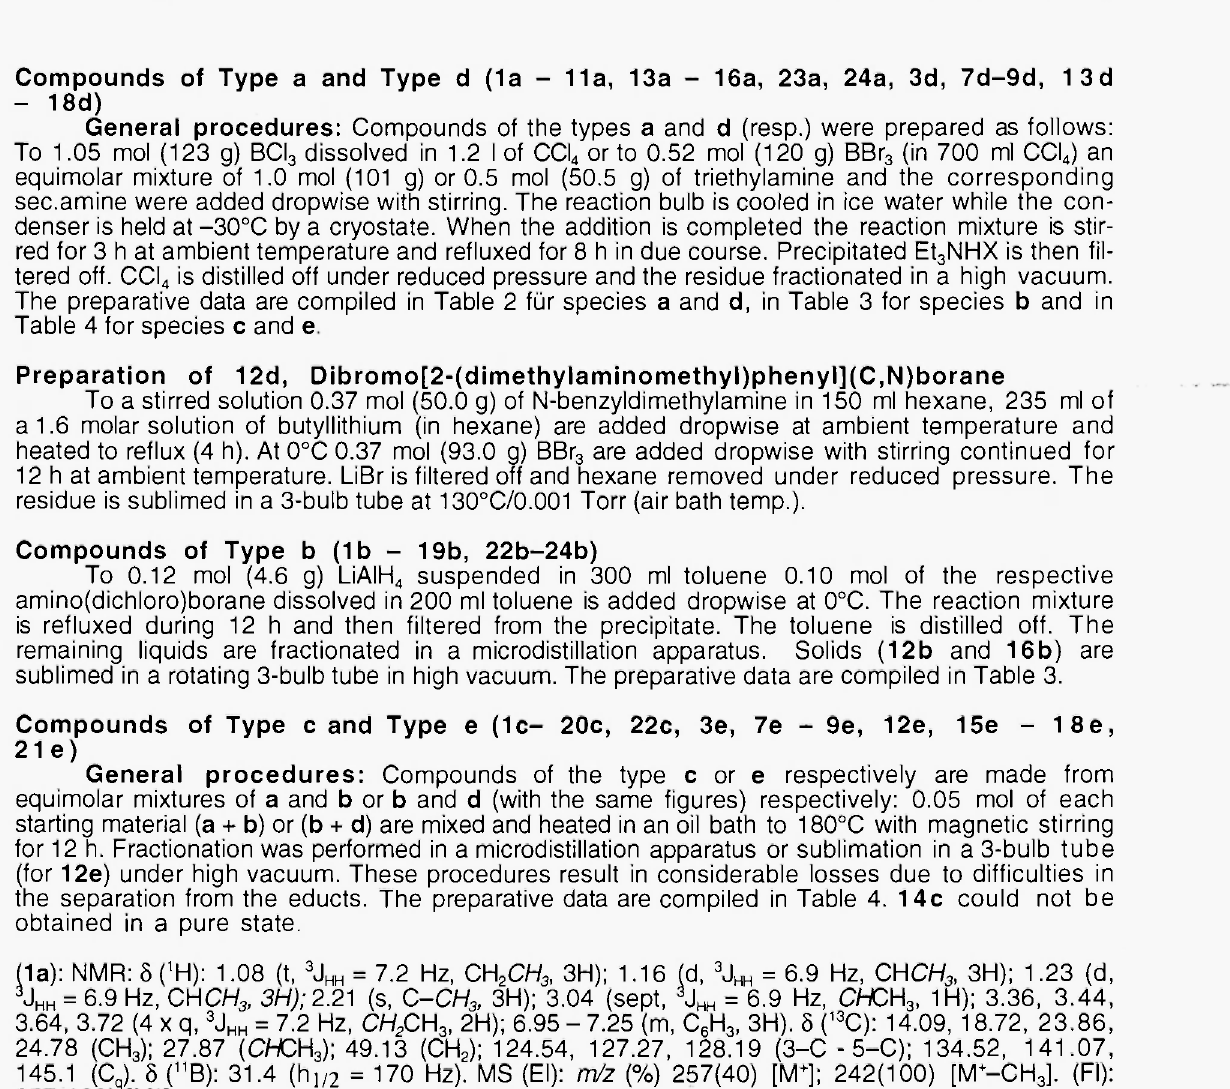
Table 4 for species c and e Preparation of 12d, Dibromo[2-(dimethylaminomethyl)phenyl](C,N)borane To a stirred solution 0.37 mol (50.0 g) of N-benzyldimethylamine in 150 ml hexane, 235 ml of a 1.6 molar solution of butyllithium (in hexane) are added dropwise at ambient temperature and heated to reflux (4 h). At 0°C 0.37 mol (93.0 g) BBr 3 are added dropwise with stirring continued for 12 h at ambient temperature. LiBr is filtered off and hexane removed under reduced pressure. The